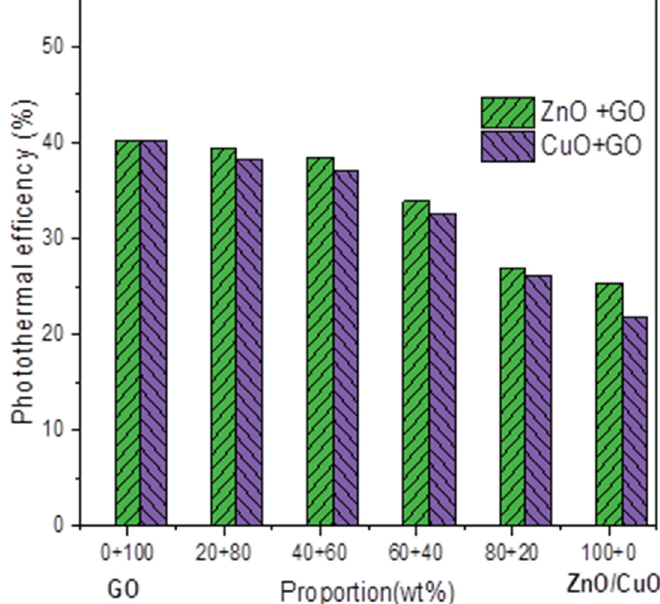
Figure 11. Photothermal conversion efficiency of CuO, ZnO, and GO nanofluids at three different wt %.